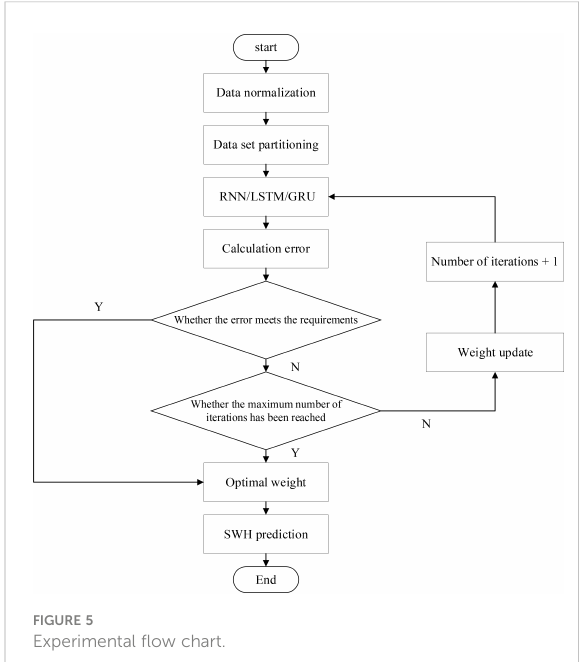
FIGURE 5 Experimental fl ow